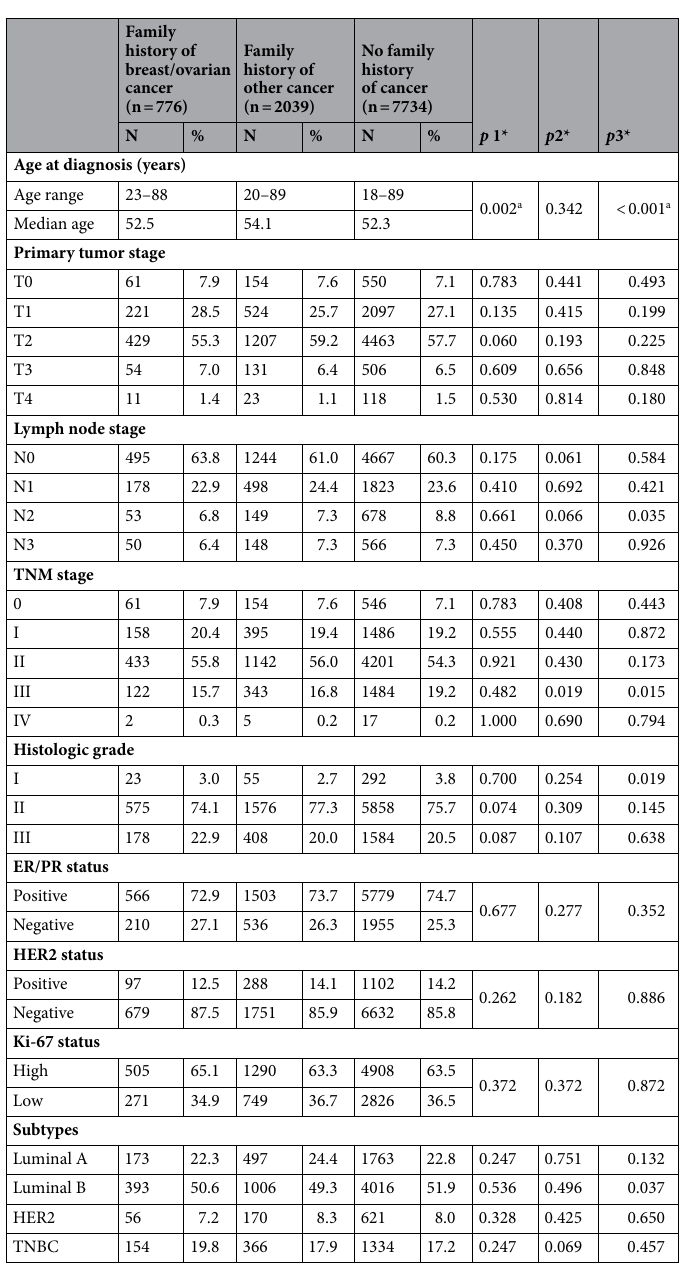
Table 3. Family history of cancer and patients’ tumor characteristics. a p < 0.05 with Tamhane T2 correction. * p 1: FHBO vs. FHO. p 2: FHBO vs. non-FH. p 3: FHO vs.